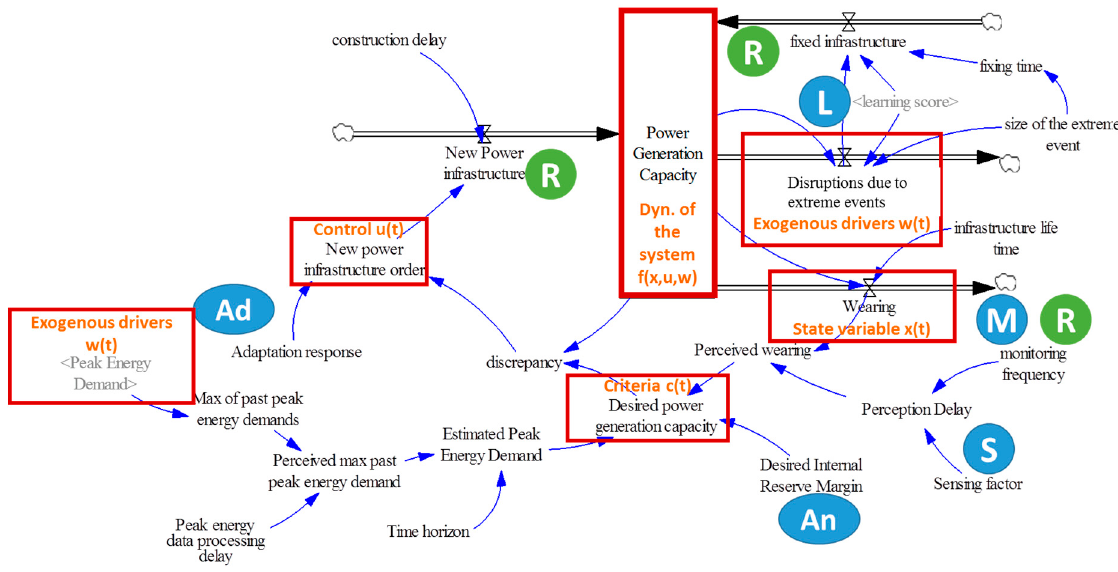
Figure 6. Influence diagram of the power infrastructure . The infrastructure is subjected to exogenous drivers and can be partially controlled. Resources (R) shown represent both costs and budget.